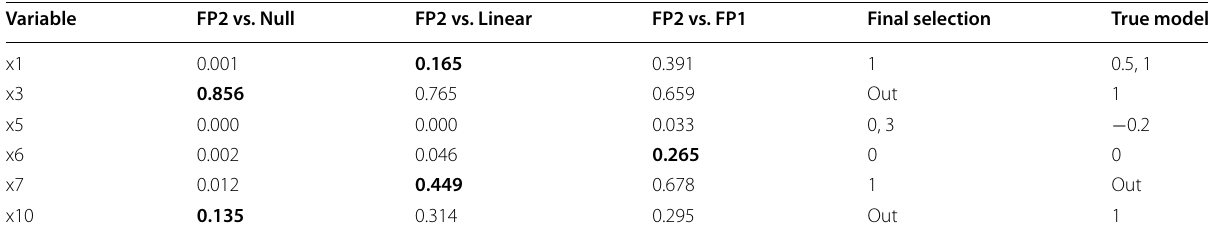
Table 1 Data A250. Univariable analysis for continuous variables. Columns 2–4 show the p -values for different FP tests; column 5 gives the final FP powers and indicates whether a variable was excluded; the last column shows the FP powers for the true multivariable model used to generate the data Variable FP2 vs. Null FP2 vs. Linear P -values in bold indicate the first non-significant test of the FSP